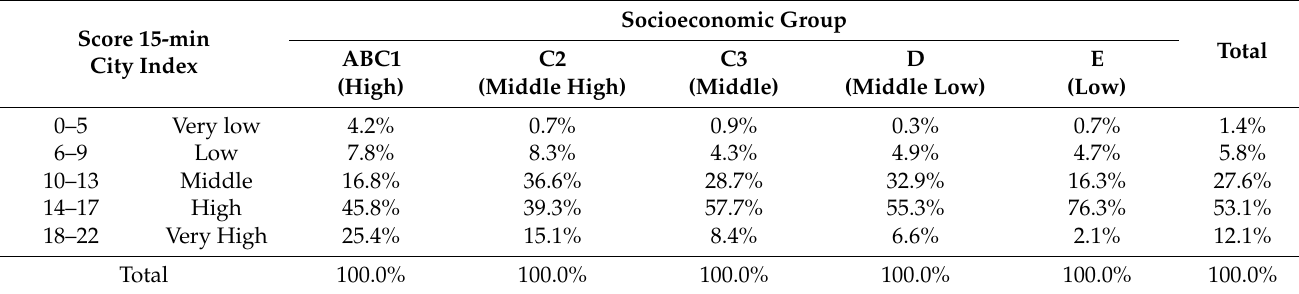
Table 4. Percentage of the older adult population according to level of accessibility and socio- economic